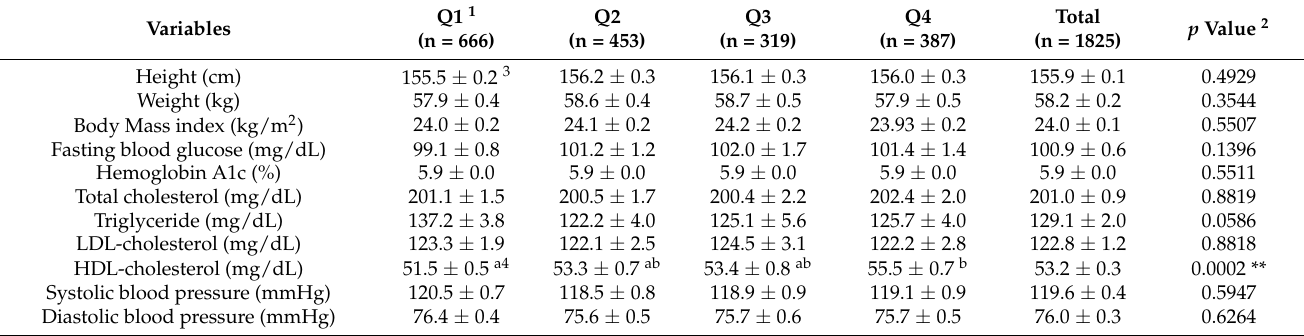
Table 3. Anthropometric measurements and blood profiles according to cow’s milk intake frequency.